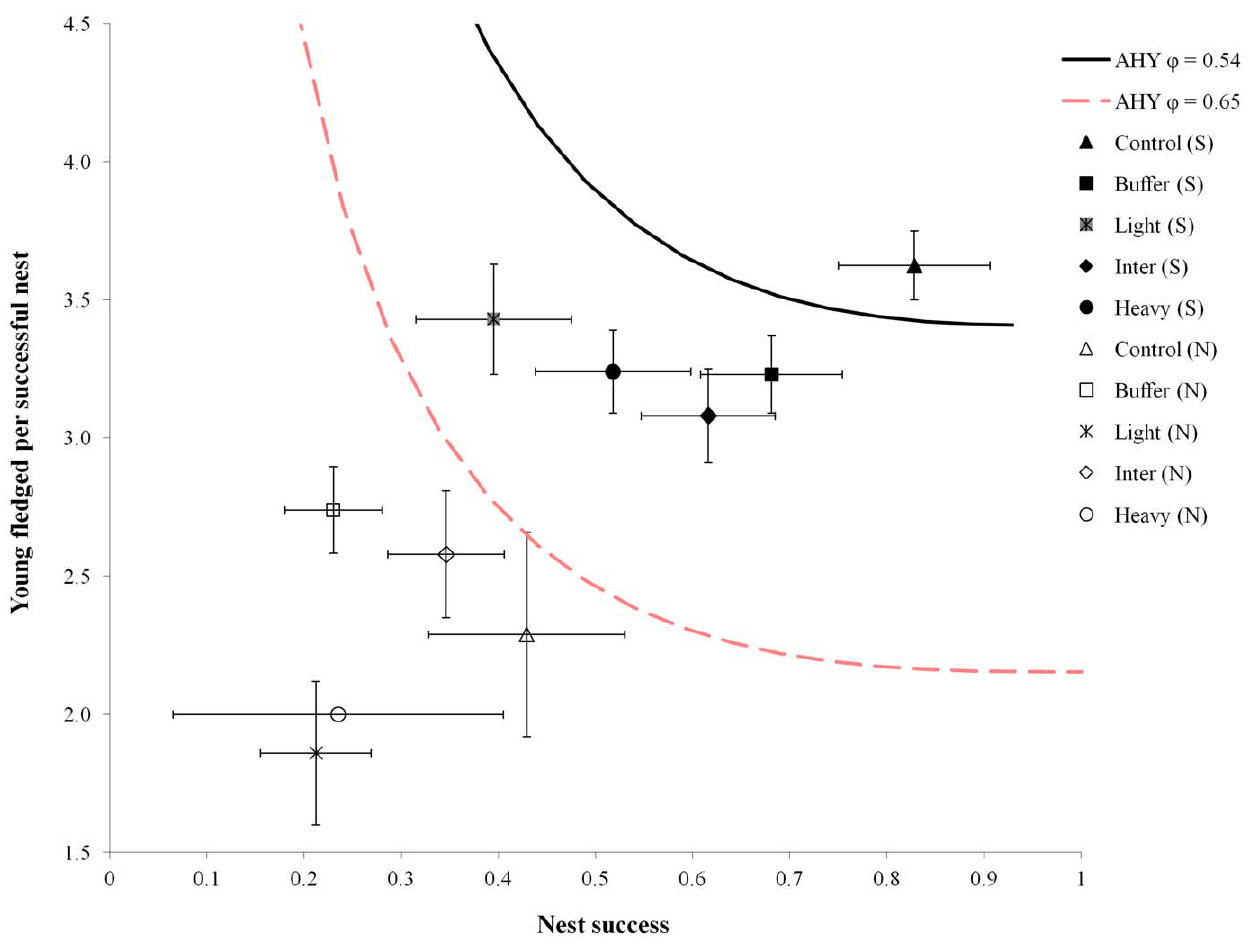
Figure 6. Graphical model of cerulean warbler source-sink dynamics in relation to regional reproductive consequences of emulated disturbances. We used point estimates of nest success and mean number of young fledged/successful nest on various treatments from the southern (S) and northern (N) regions, 2008–10. Error bars indicate 6 1 SE. Two possible lambda threshold curves are displayed, each based on a published annual survival rate for cerulean warblers: (1) from Ontario (54% AHY survival), and (2) from Venezuela (65% AHY survival). Points to the left of (or below) the threshold curve, for each given survival rate, represent decreasing, or sink populations, and points to the right of (or above) the curve represent increasing, or source populations. HY survival was considered to be 0.5 of the AHY rate and three re-nesting attempts were assumed to occur for all failed nests.